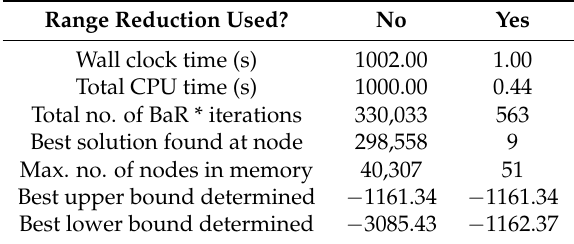
Table 8. The solution statistics for (11) using BARON, with 1000 s of solver time allocated in each